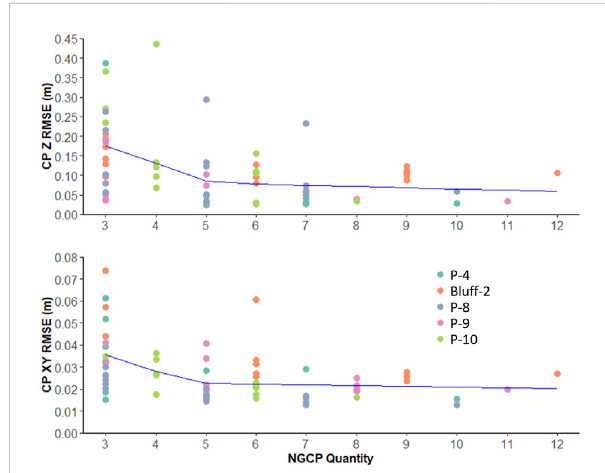
FIGURE 9 Piecewise regression of NGCP quantity vs. vertical (Z) RMSE (top) and horizontal (XY) RMSE (bottom). Each point represents theRMSE of a single replication for a given quantity of NGCPs, while point colors represent the site from which the RMSE is derived. Boxes represent the interquartile range (IQR), whiskers represent points < 1.5*(IQR) above or below the IQR, and dots represent points > 1.5*(IQR) above or below the IQR. Blue lines represent piecewise linear regression trend lines. Outliers greater than 3 times the interquartile range above the upper quartile of each NGCP quantity are not shown (top n = 6, bottom n =